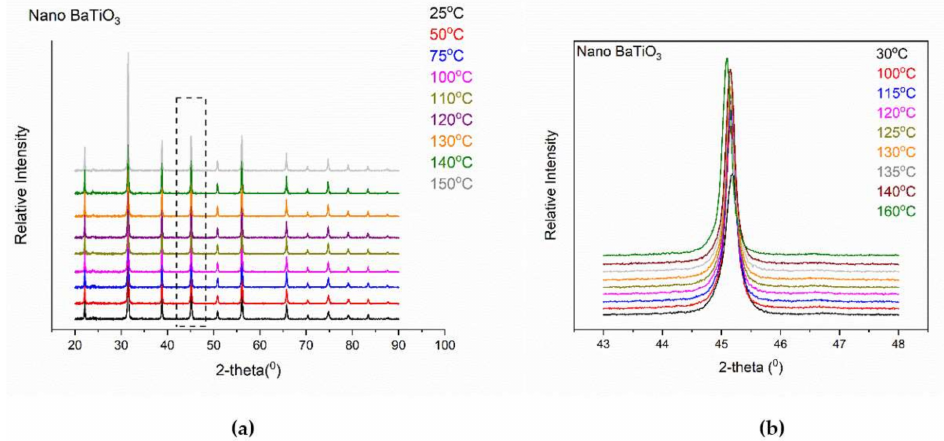
Figure 5. XRD patterns of nano-BT particles, at various temperatures, performed under the following experimental conditions: ( a ) increment = 0.02 ◦ and scan speed = 0.5s and ( b ) increment = 0.01 ◦ and scan speed = 10s.